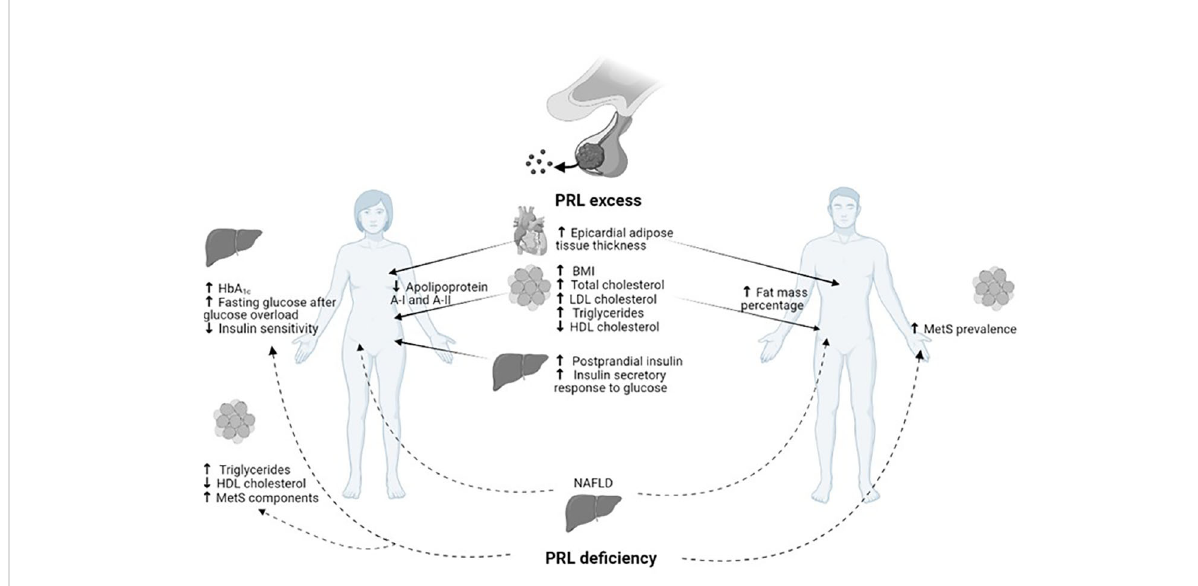
FIGURE 1 Gender related metabolic impact of PRL excess and de fi